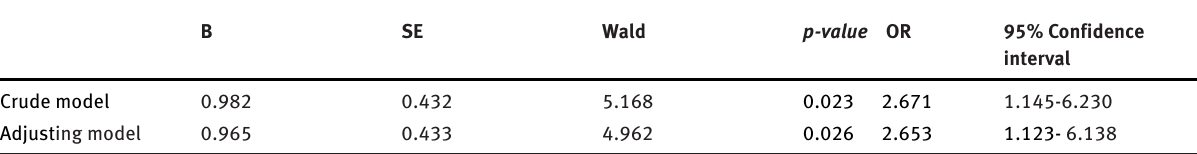
Table 2: Results of Stepwise multiple logistic regression analysis of red blood cell distribution width